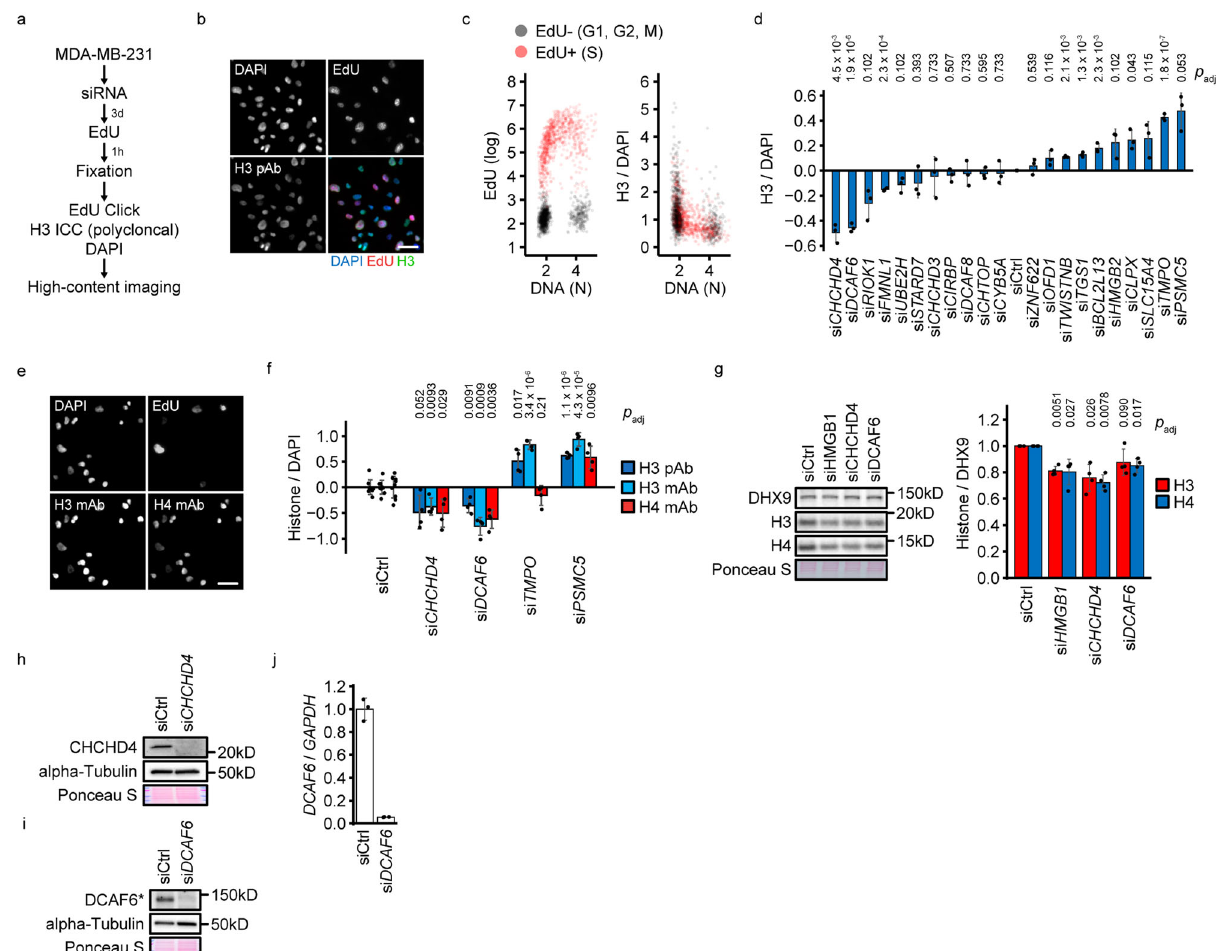
Fig. 6 Screen for histone level modulators. a Scheme of the siRNA screen for histone density modulators. b , c High-content imaging analysis of histone H3. MDA-MB-231 cells were transfected with the scrambled control siRNA and processed as in ( a ). Representative microscopy images are shown in ( b